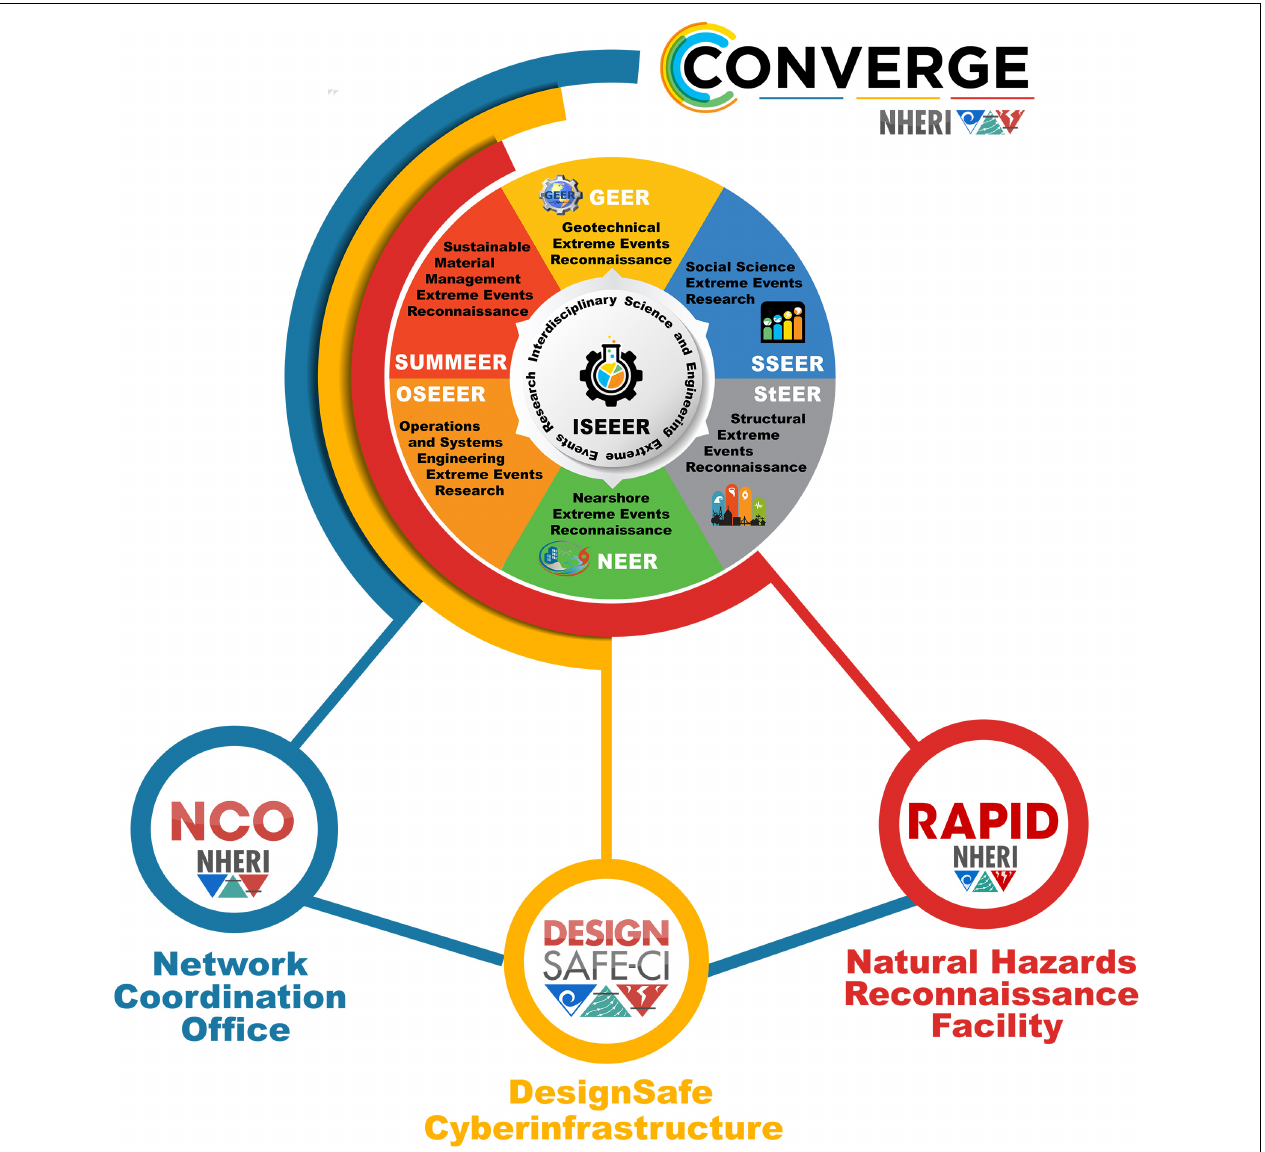
FIGURE 7 | NSF-supported CONVERGE leadership corps for extreme events